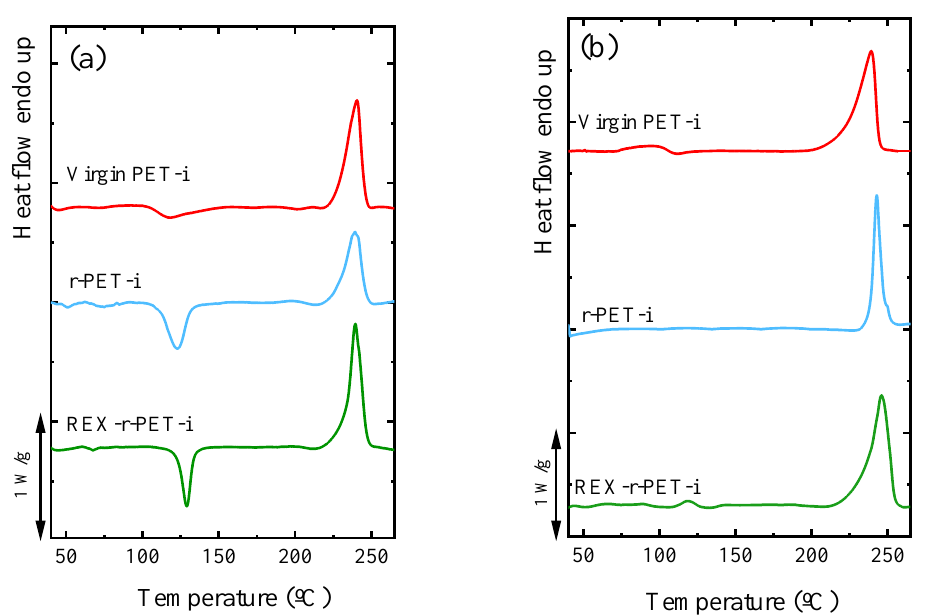
Figure 13. ( a ) Young’s modulus, ( b ) yield stress, and ( c ) strain-at-break values of virgin PET, r- PET, and REX-r-PET.